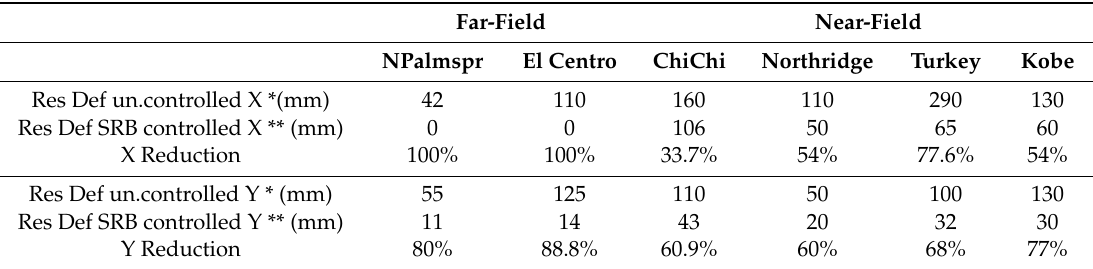
Table 9. The mid-span residual deformation values before and after applying the SRB, in two directions, X and